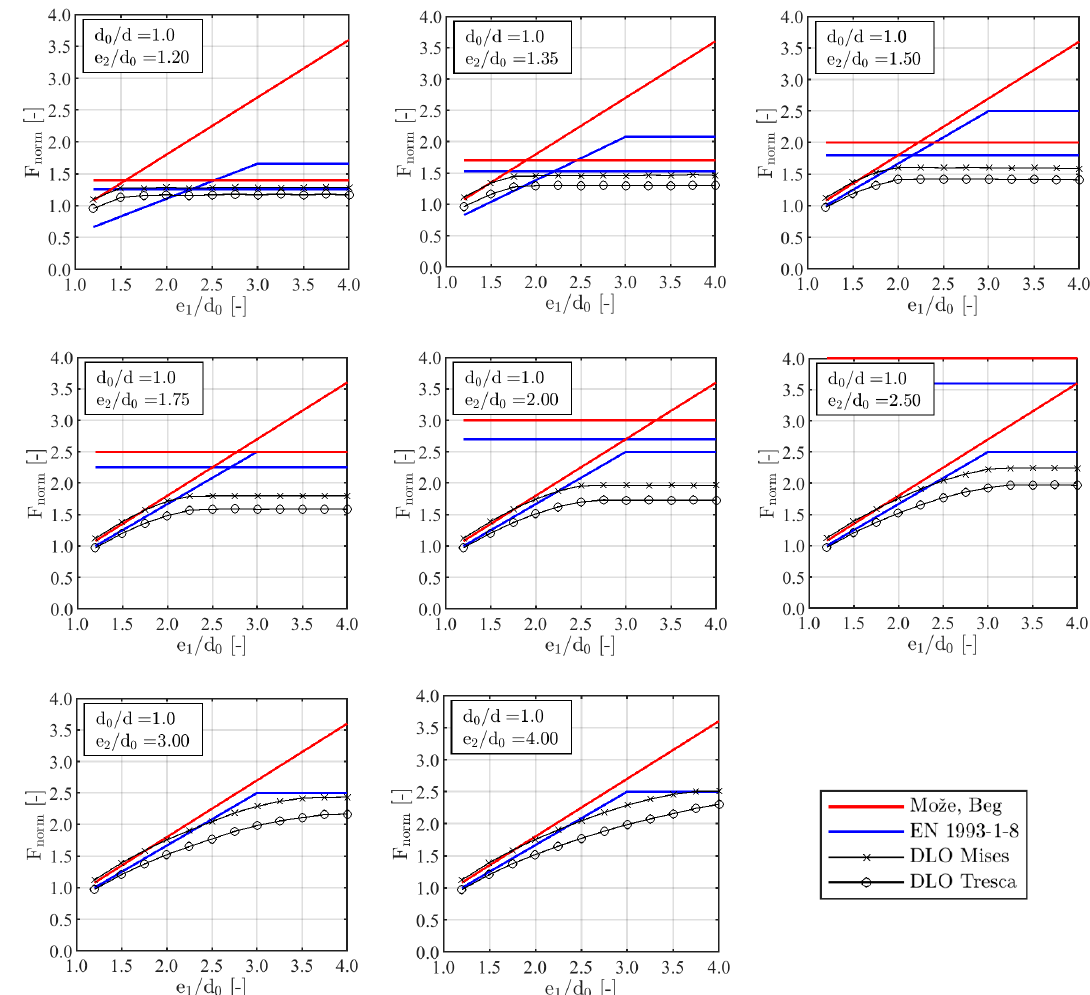
Figure 21. Comparison of normalized loads for d 0 /d =